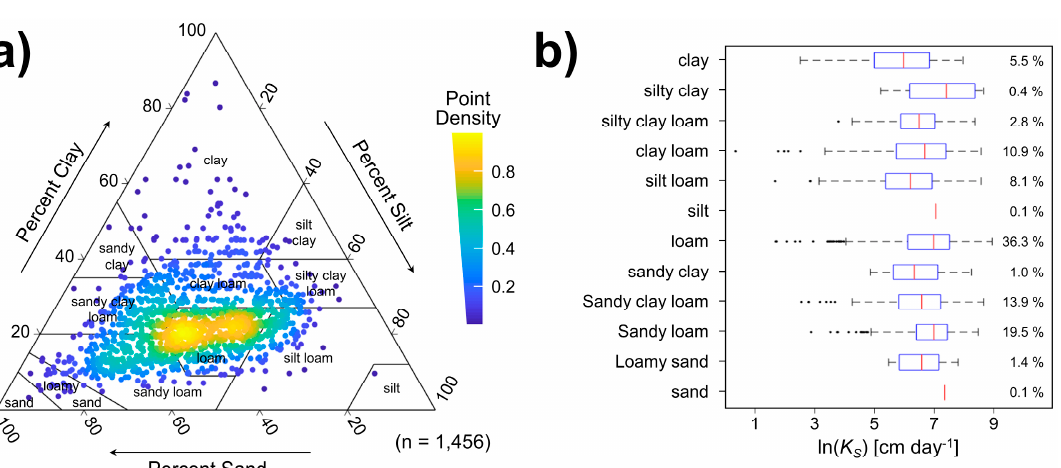
Figure 2. ( a ) Distribution of forest soils used in this study ( n = 1456) across USDA textural classes and ( b ) ranges of the saturated hydraulic conductivity ( K s ) and percent database by soil texture class. The elevation, slope, topographic wetness index (TWI; Equation (2)), upper catchment area (CA), plan curvature, and profile curvature were collected as the topographic features. The